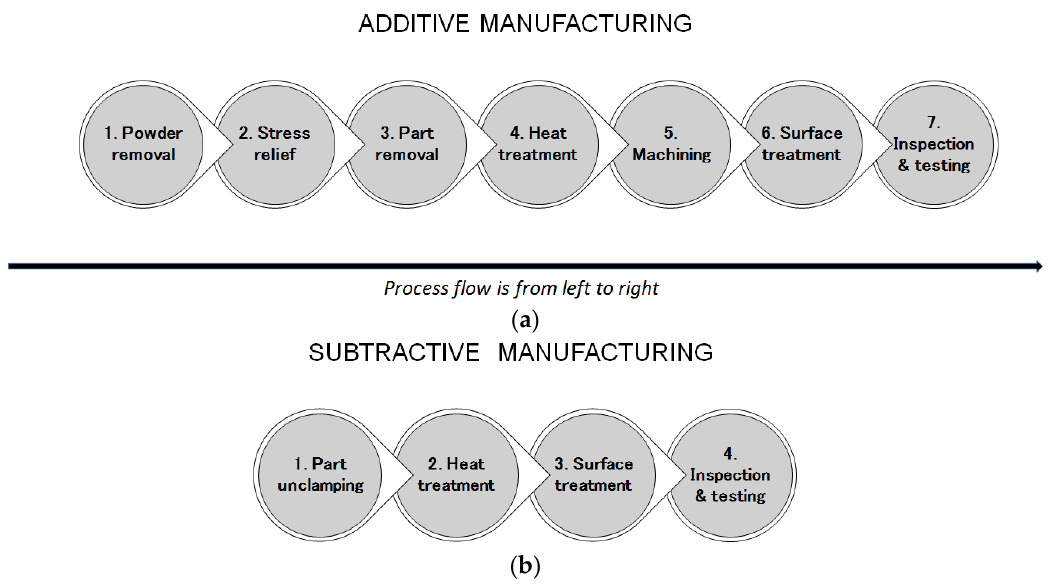
Figure 3. Possible post-processing steps for parts fabricated additively ( a ) and using material removal processes ( b ).